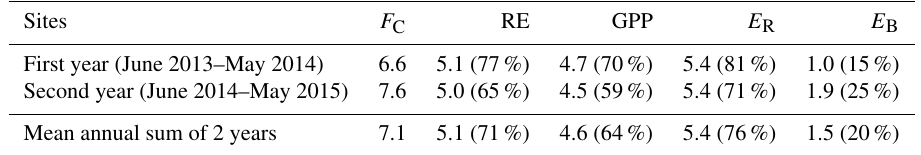
Table 4. Gap-filled annual budgets for F C (observed by EC measurement) and its components, indicating ecosystem respiration (RE), photosynthetic uptake by vegetation (GPP), vehicle emissions ( E R ), and building emissions ( E B ). All fluxes are in kgCO 2 m − 2 yr − 1 .